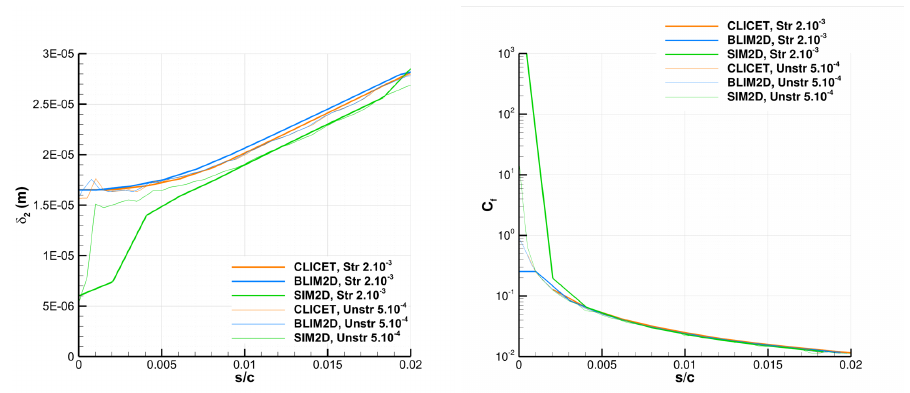
Figure A5. Solution produced by CLICET, BLIM2D, and SIM2D for the momentum thickness and the skin friction coefficient in the laminar area of Han and Palacios’s experiment for several meshes. ( Left ): δ 2 . ( Right ): C f .